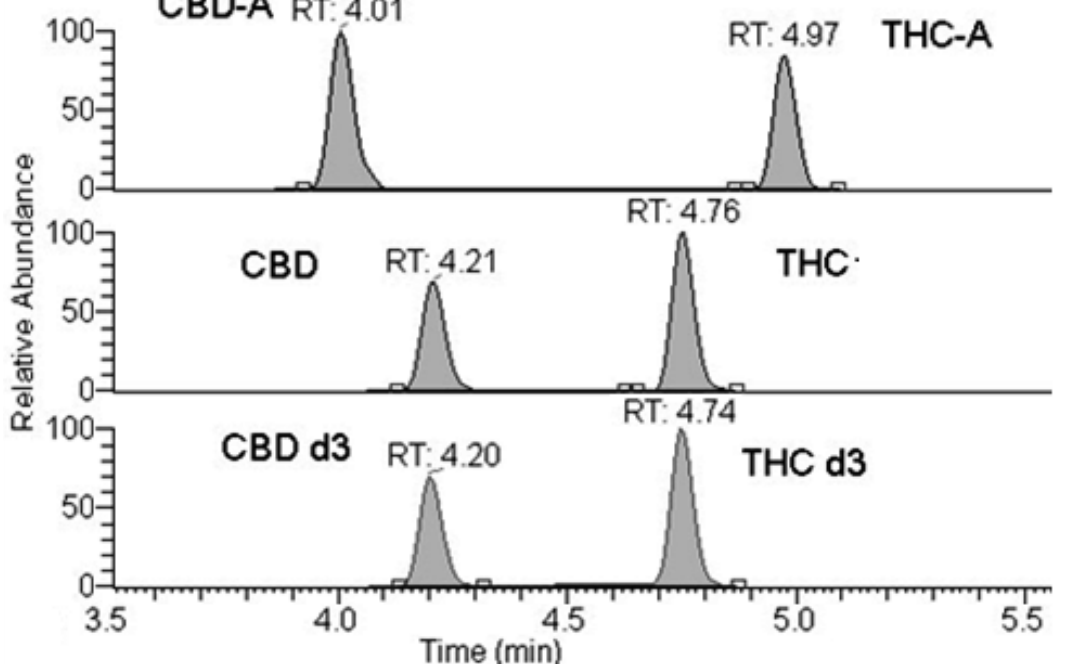
Figure 1 . Chromatographic peaks and retention times of CBD, CBD-A, THC and THC-A and deuterated internal standards.